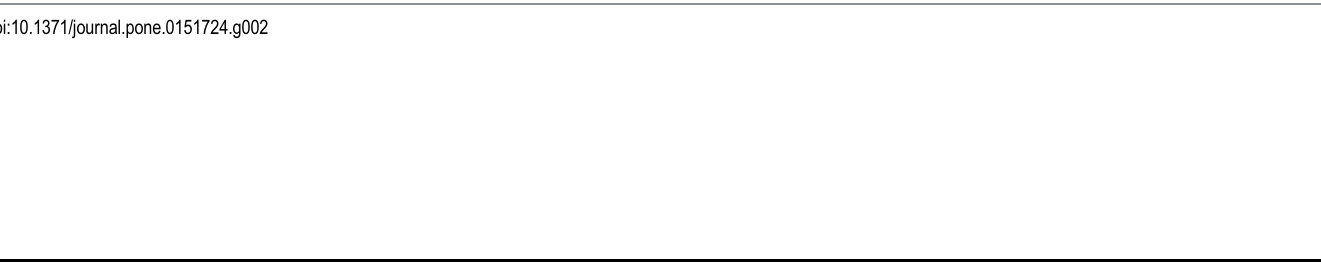
Fig 2. Consort diagram for an individual patient data meta-analysis of the effectiveness of macrolide antibiotics to treat multi-drug resistant tuberculosis. Group allocation was independent of which other antibiotics were concurrently used. * Some patients were excluded on the basis of more than one